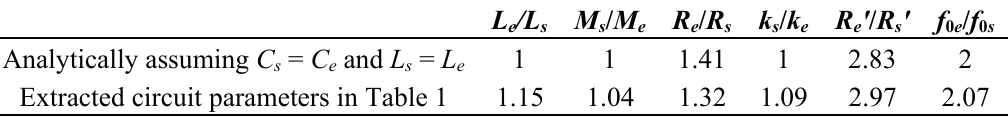
L /L M / M R / R k / k R ' / R ' f / f e s s e e s s e e s 0 e 0 s = C and L = L 1 s e s e